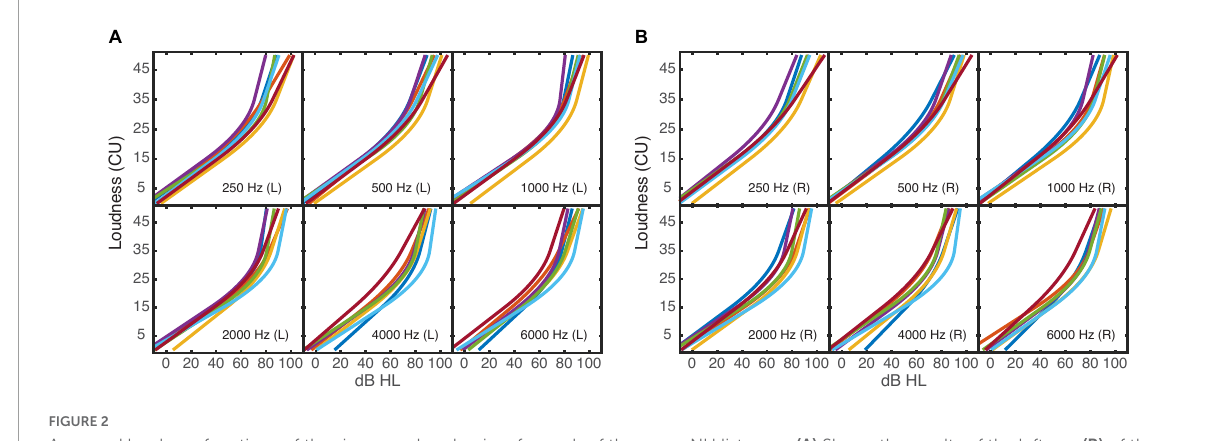
FIGURE2 Averaged loudness functions of the six narrowband noises for each of the seven NH listeners. (A) Shows the results of the left ear, (B) of the right